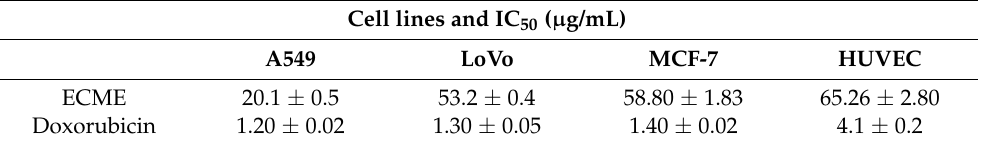
Figure 2. Effect of ECME on the viability of various cancer cells. Cells were treated with increasing concentrations for 48 h, and cell survival was estimated by an MTT assay. The percentage of cells’ survival was determined as compared with the untreated cells. Table 3. IC 50 of ECME against cancer (A549, LoVo, and MCF-7) and normal (HUVEC) cell lines as measured by MTT assay. Values were measured in triplicates and represented as mean ± SD and presented as µg/mL.